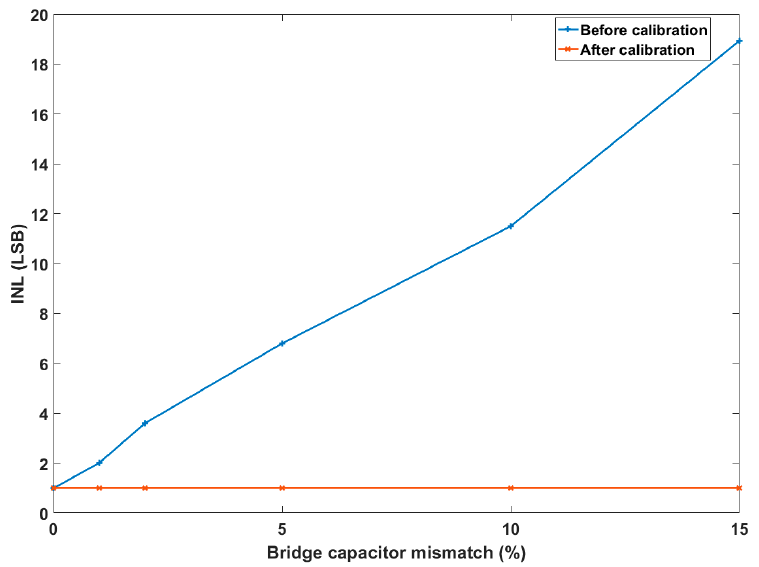
Figure 7. INL simulation results, before and after calibration when a mismatch was applied to the segmentation bridge capacitor alone.